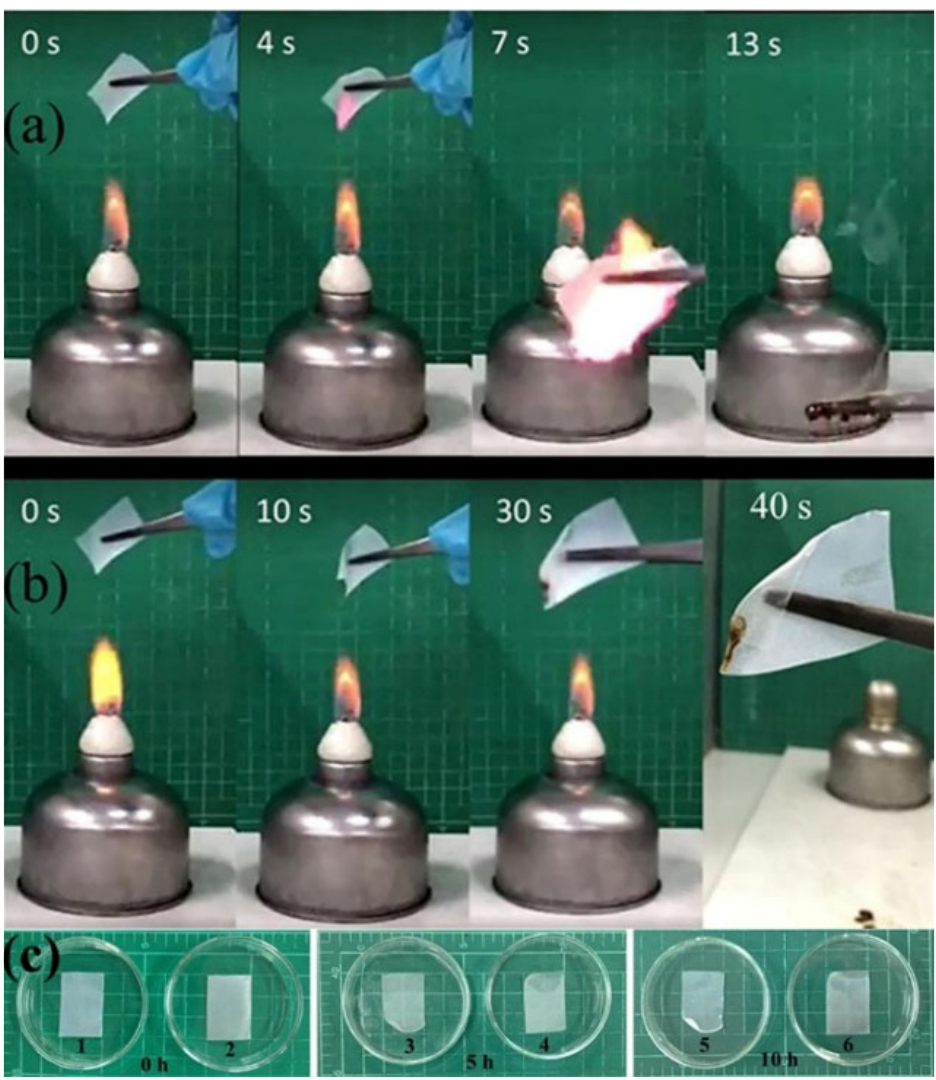
Figure 10. Flammability test of ( a ) PEO 20%LiCF 3 SO 3 5%HNT, ( b ) PEO 20%LiCF 3 SO 3 5%HNT 15 US. ( c ) dimensional stability at 60 °C of (1), (3), (5) for PEO 20%LiCF 3 SO 3 5%HNT at 0 h, 5 h and 10 h, and (2), (4), (6) for PEO 20%LiCF 3 SO 3 5%HNT 15 US at 0 h, 5 h, 10h.